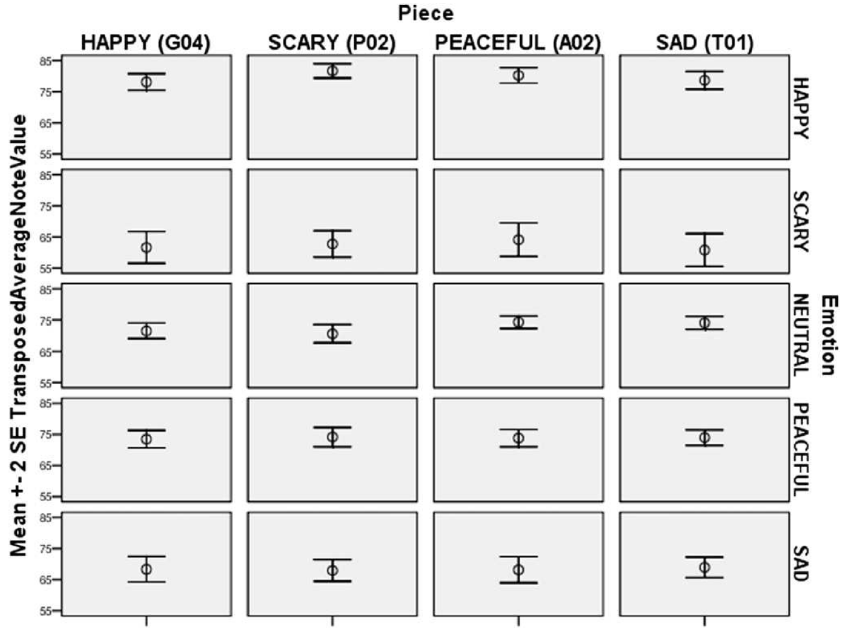
Figure 8. Relation between the register and expressed emotion (mean values and range). Reprinted with permission from [85]. 2011,